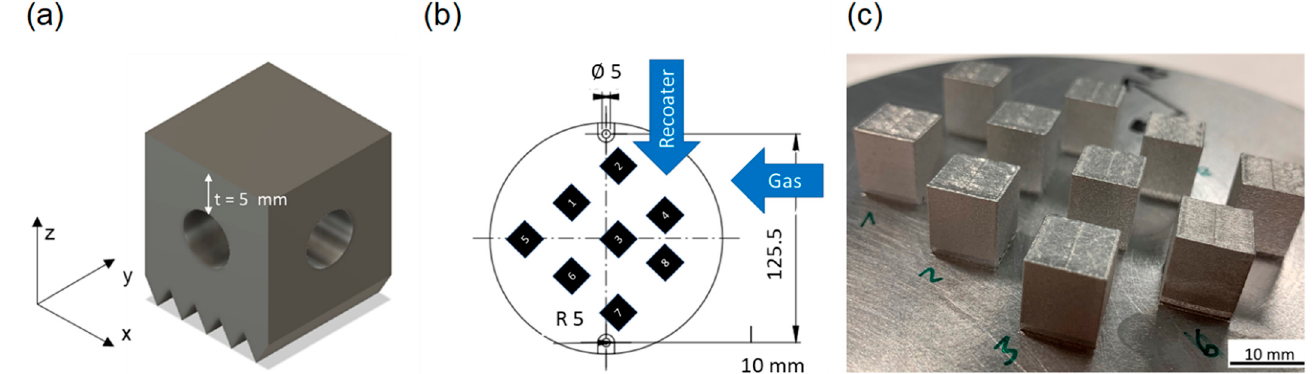
Figure 2. ( a ) Schematic representation of a cube with circular channels; ( b ) Positioning of cubes with circular channels; ( c ) Build job with cubes, the green numbers indicated sample numbers.